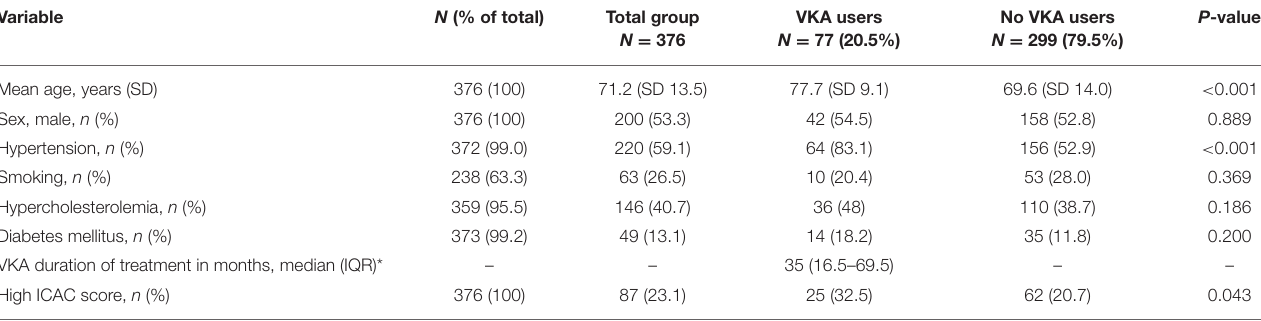
TABLE 1 | Patient characteristics.